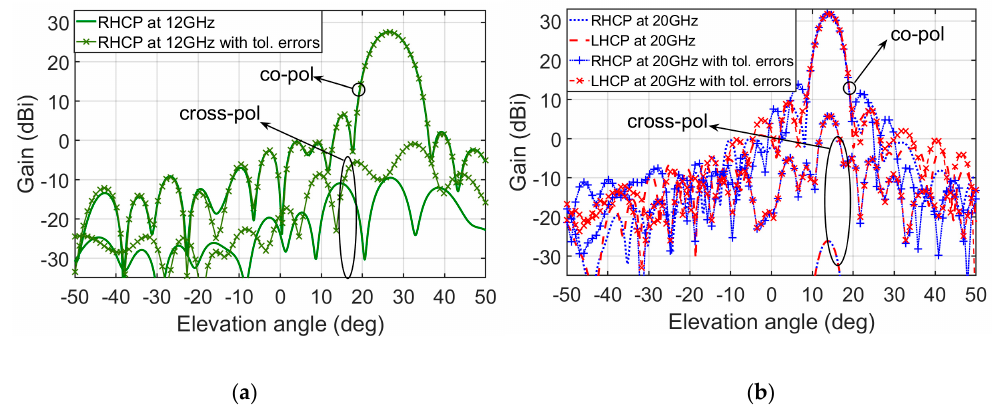
Figure 11. Comparison between the simulated radiation patterns in the elevation plane shown in Figure 10 and the simulated radiation patterns that take into account the tolerance errors of permittivity and length variations of the dipoles and arcs. ( a ) At 12 GHz for RHCP. ( b ) At 20 GHz for both RHCP and LHCP.